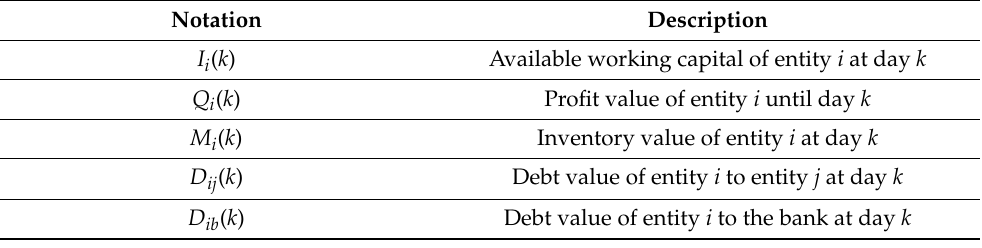
Table 1. State variables.